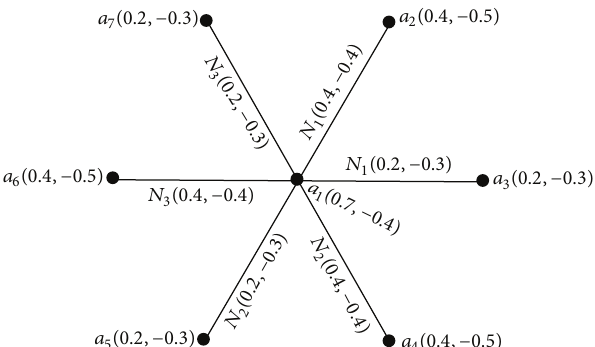
Figure 10: Totally strong self-complement